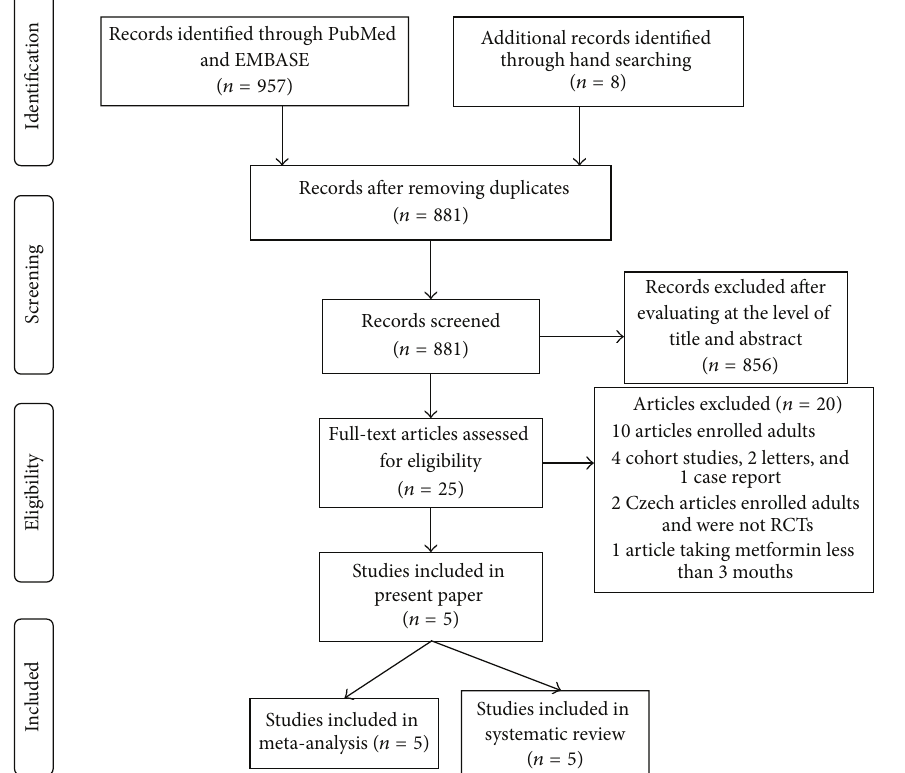
Figure 1: QUOROM (quality of reporting of meta-analyses) flow-chart of the study selection